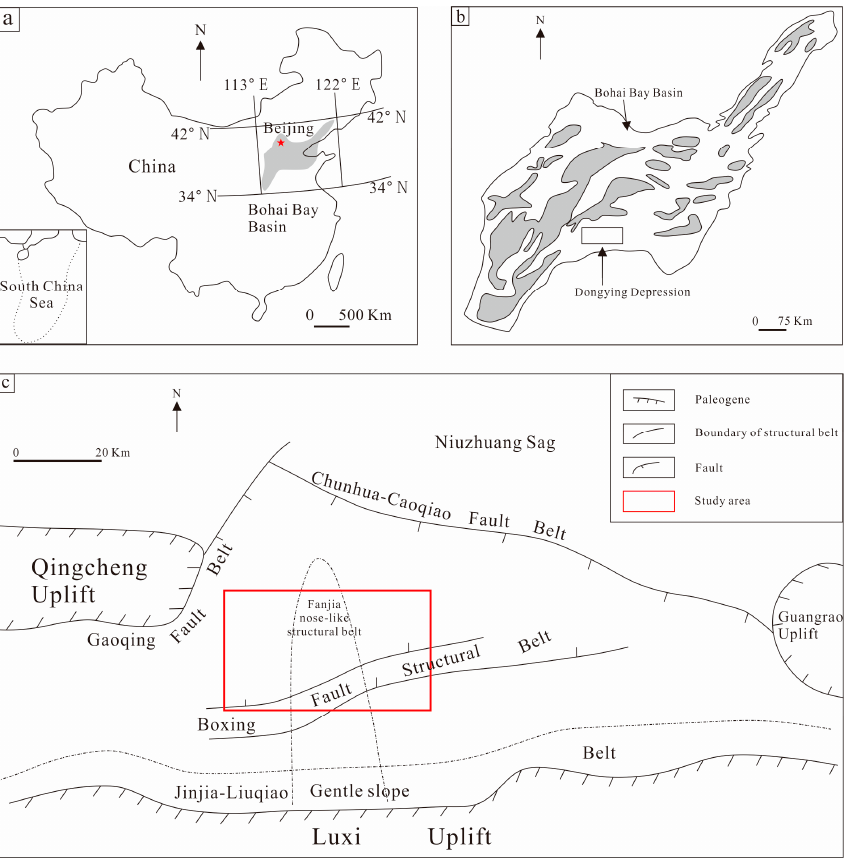
Figure 1. Structural distribution map of study area. ( a ) Location of Bohai Bay Basin; ( b ) location of Dongying depression in Bohai Bay Basin; ( c ) study area in Dongying depression.